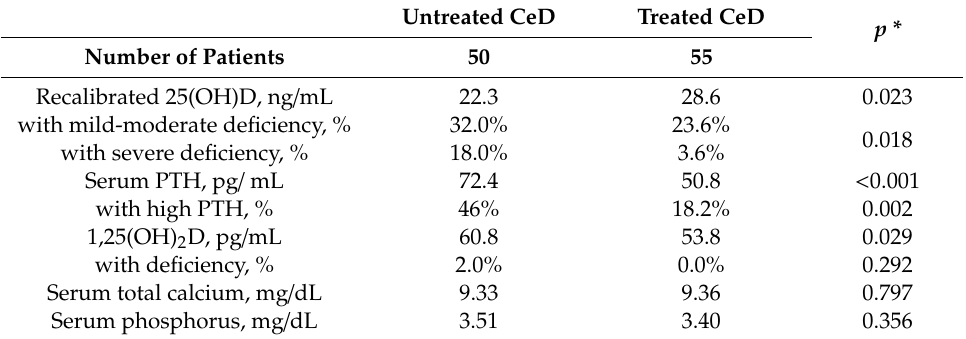
Table 2. Lab test comparisons between untreated and treated celiac disease (CeD): Mean or